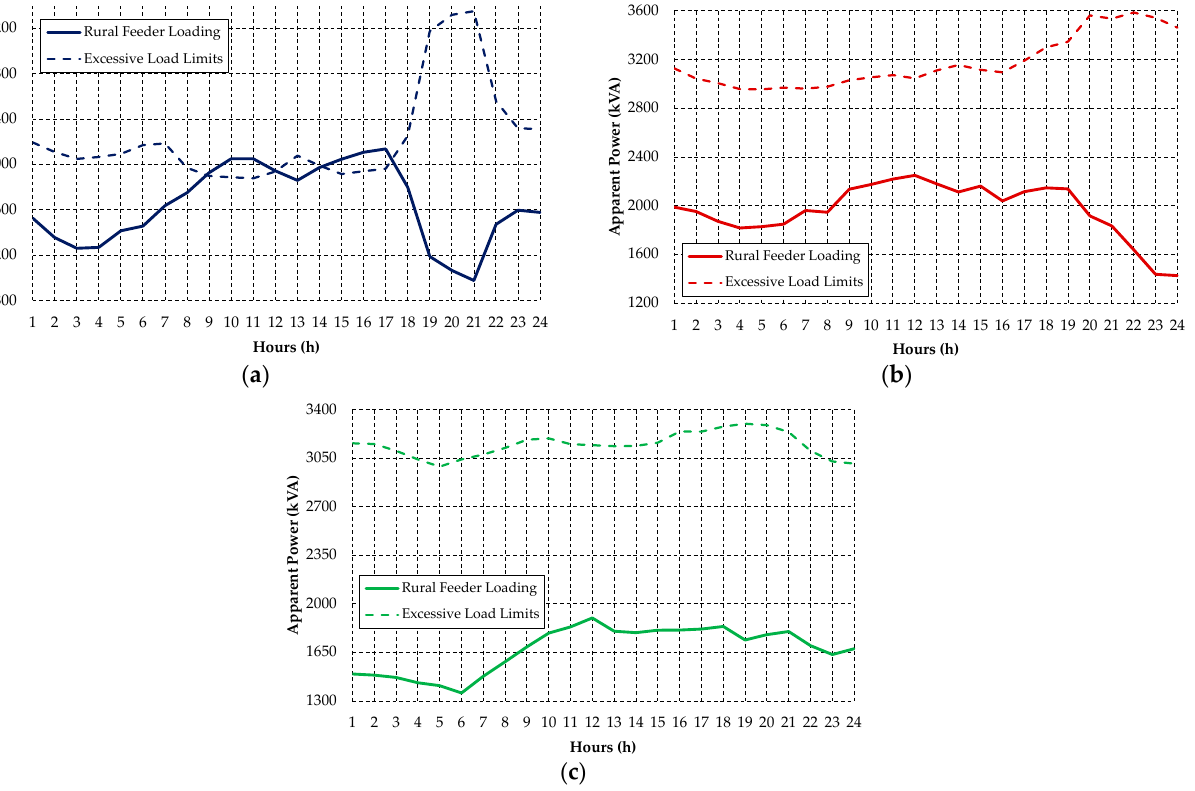
Figure 22. Apparent power and limits for excessive load on the Rural Feeder C in the period of ( a ) weekday, ( b ) Saturday, and ( c ) Sunday. Source: The authors.